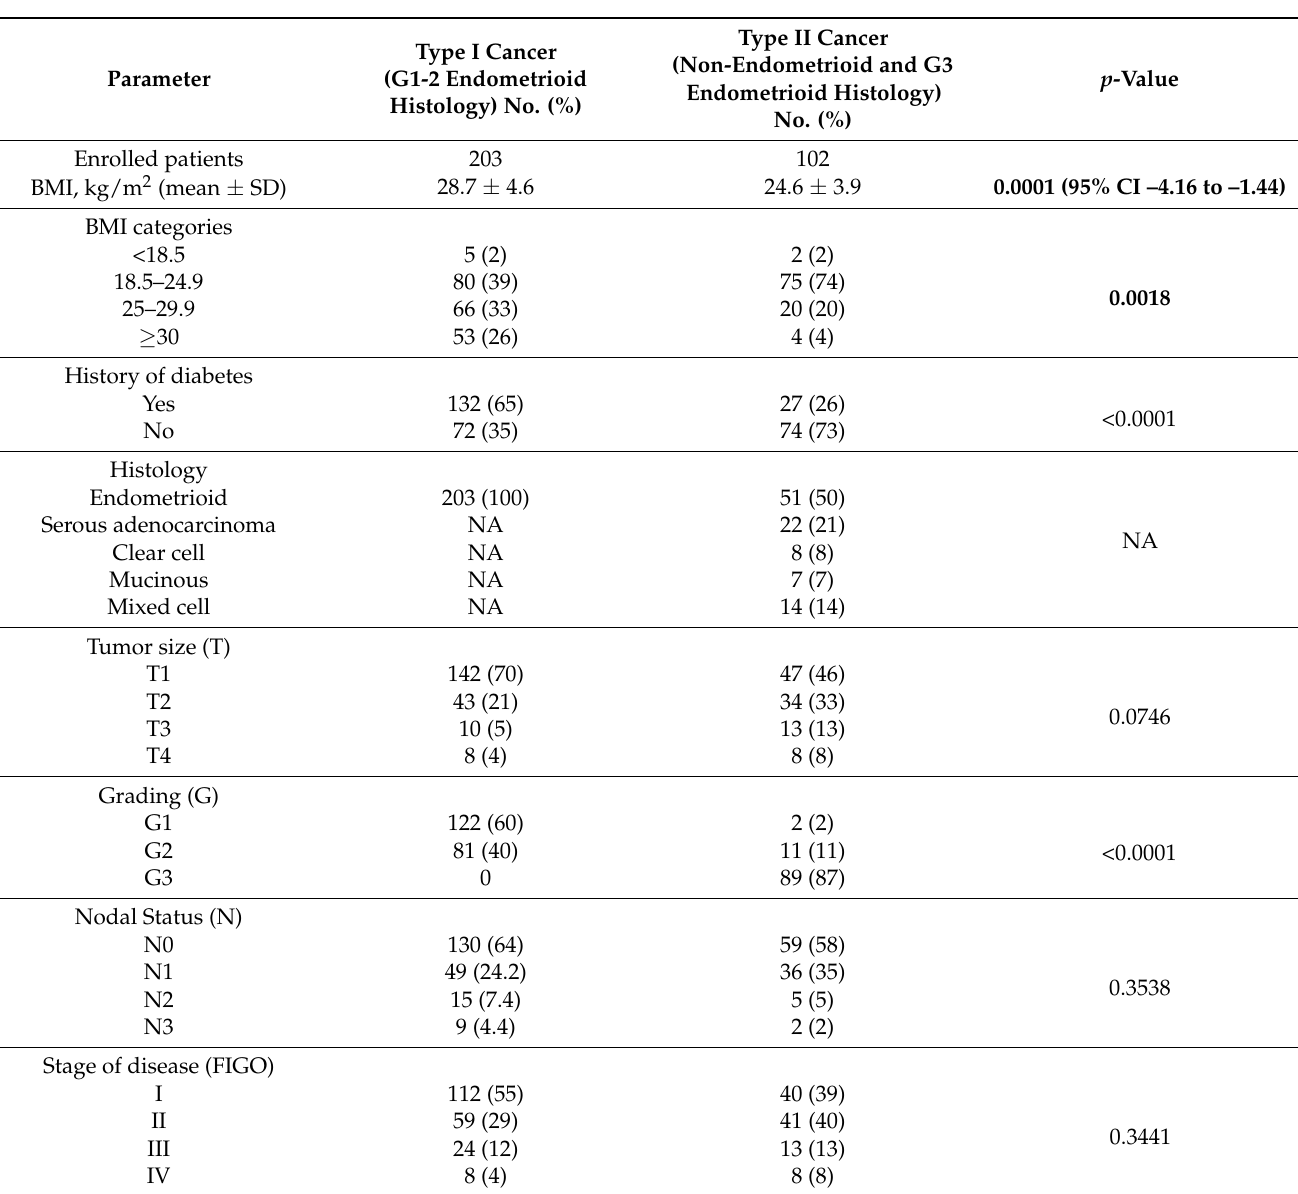
Table 2. Baseline clinical and tumor characteristics of endometrial cancer patients according to tumor